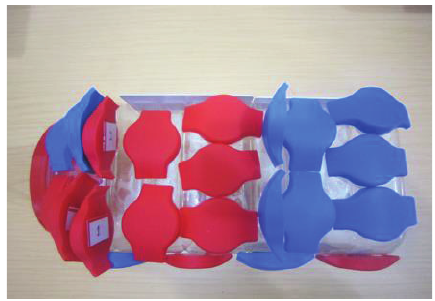
Figure 2: Group of RFID tags tested for this study.